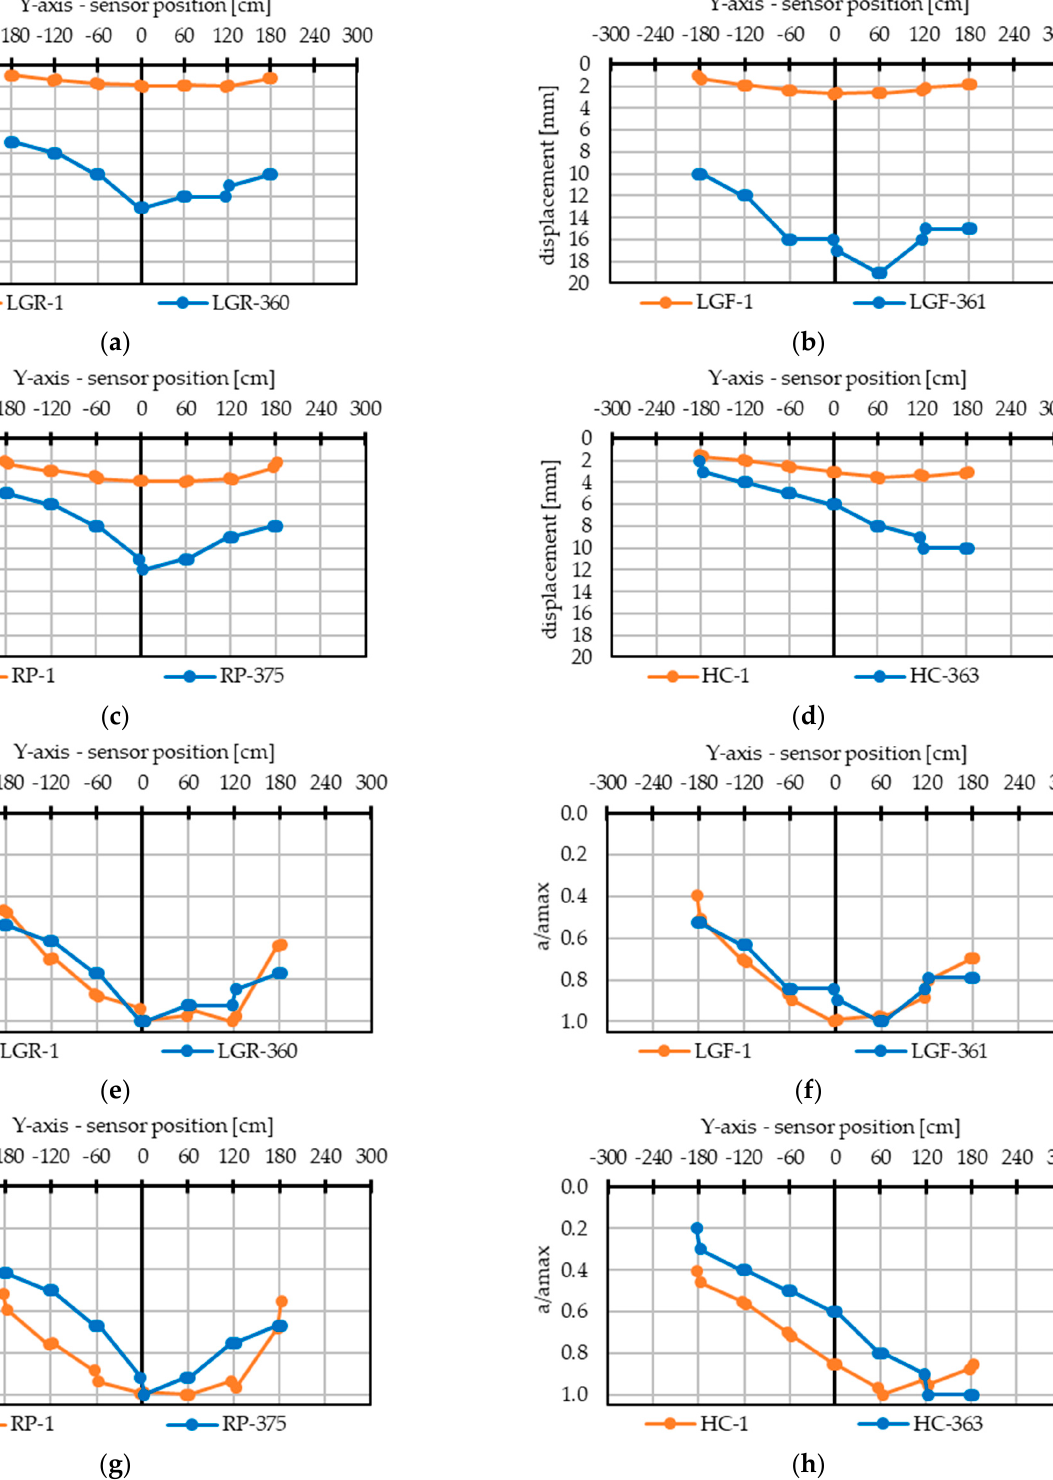
Figure 20. Comparison of deflection characteristics on the Y-axis during the load period for slab made of ( a ) lattice girder panels with rebars; ( b ) lattice girder panels with fibre reinforcement; ( c ) prestressed ribbed panels; ( d ) hollow-core panels. ( e – h ) First and last day performance comparisons for each model.